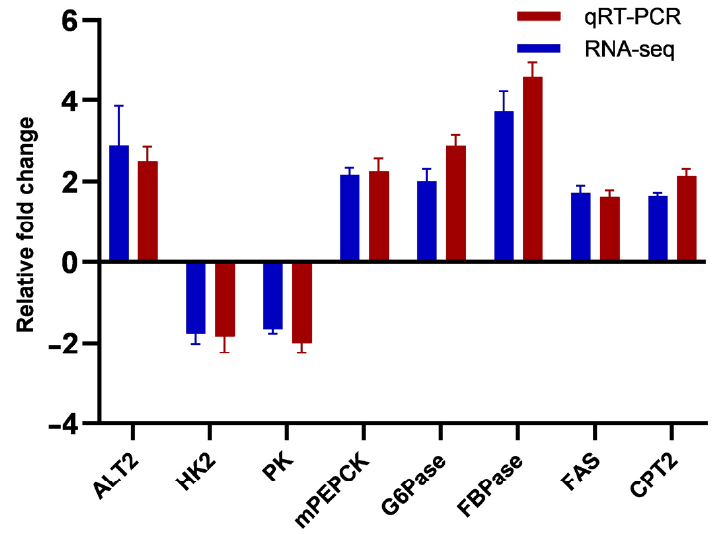
Figure 7. RNA-Seq validation by quantitative PCR (qPCR). Note: It was conducted to confirm the repeatability of the RNA-Seq pipeline’s differential expression data. These data are reported as means ± error ( n = 3).